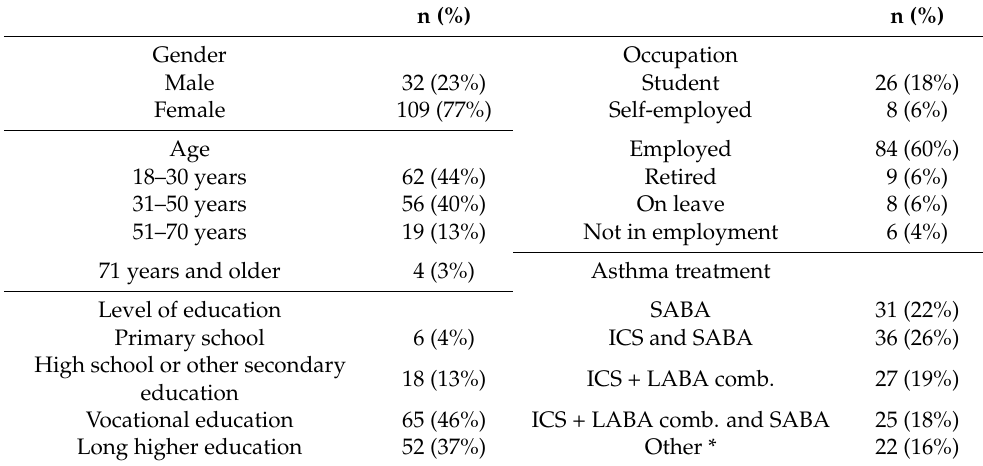
Table 1. An overview of the questionnaire respondents (n = 141). *Other: means here the use of ICS or LABA in monotherapy, or SABA in combination with LABA or a short-acting anticholinergic (SAMA). n (%) n